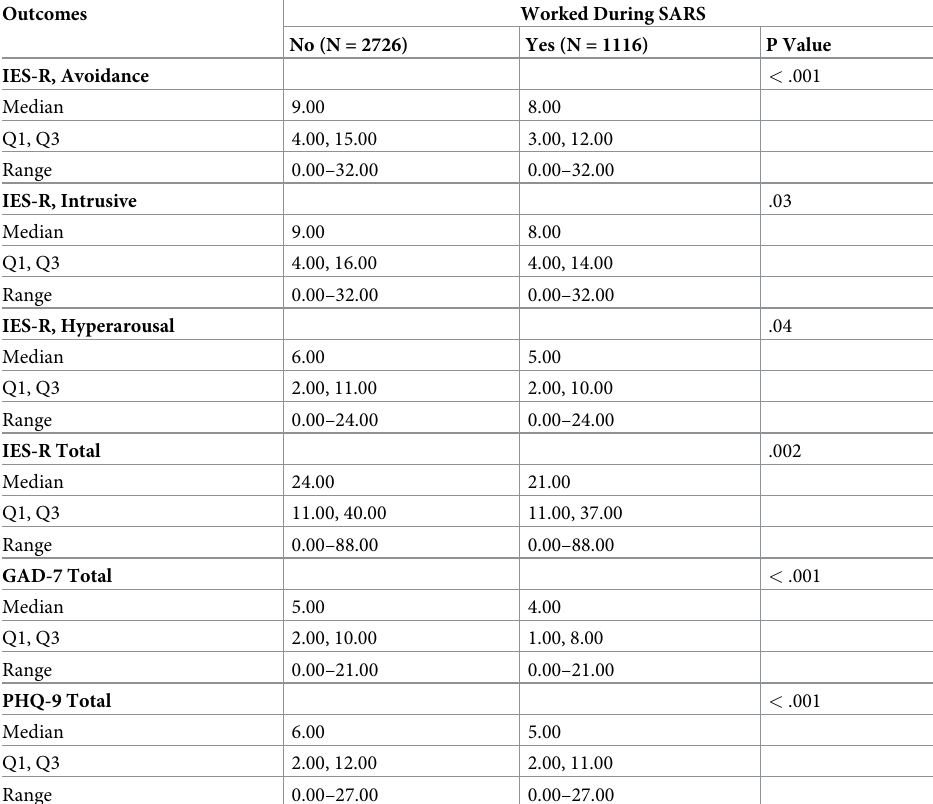
SARS: Severe Acute Respiratory Syndrome; IES-R: 22-item Impact of Event Scale-Revised; GAD-7: 7-item Generalized Anxiety Disorder; PHQ-9: 9-item Patient Health Questionnaire; Q1: 1 st Quartile median score; Q3: 3 rd Quartile median